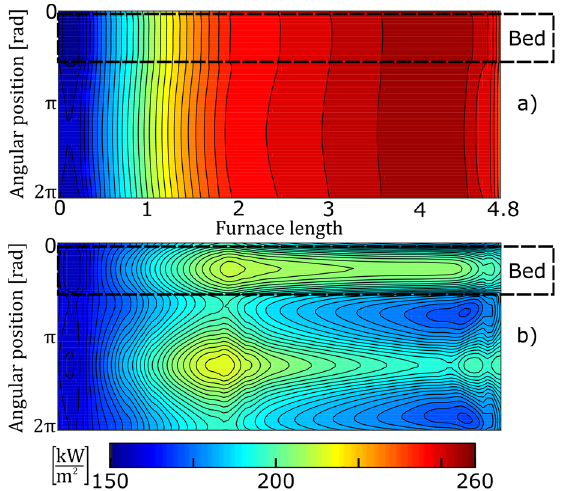
Figure 10. Modelled incident radiative heat flux to the furnace wall and the introduced bed material. The bed temperature is set to ( a ) the closest gas temperature; ( b ) a linear increase from 100 °C at the furnace outlet (right end) to 1050 °C at the burner (left end).